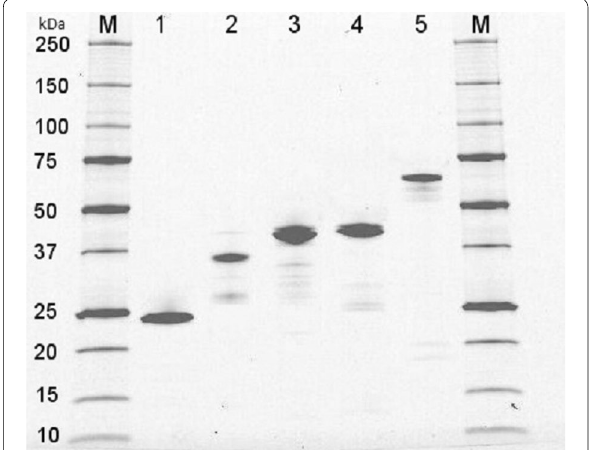
Fig. 2 SDS-PAGE analysis of the five purified recombinant metagenomic xylanases. Two micrograms of each purified enzyme was loaded on a 4–20% Criterion ™ TGX Stain-Free ™ Precast gradient gel (Bio-Rad) and visualized on a Bio-Rad Criterion Strain-free imaging system. Lanes: M—Prestained Precision Plus protein